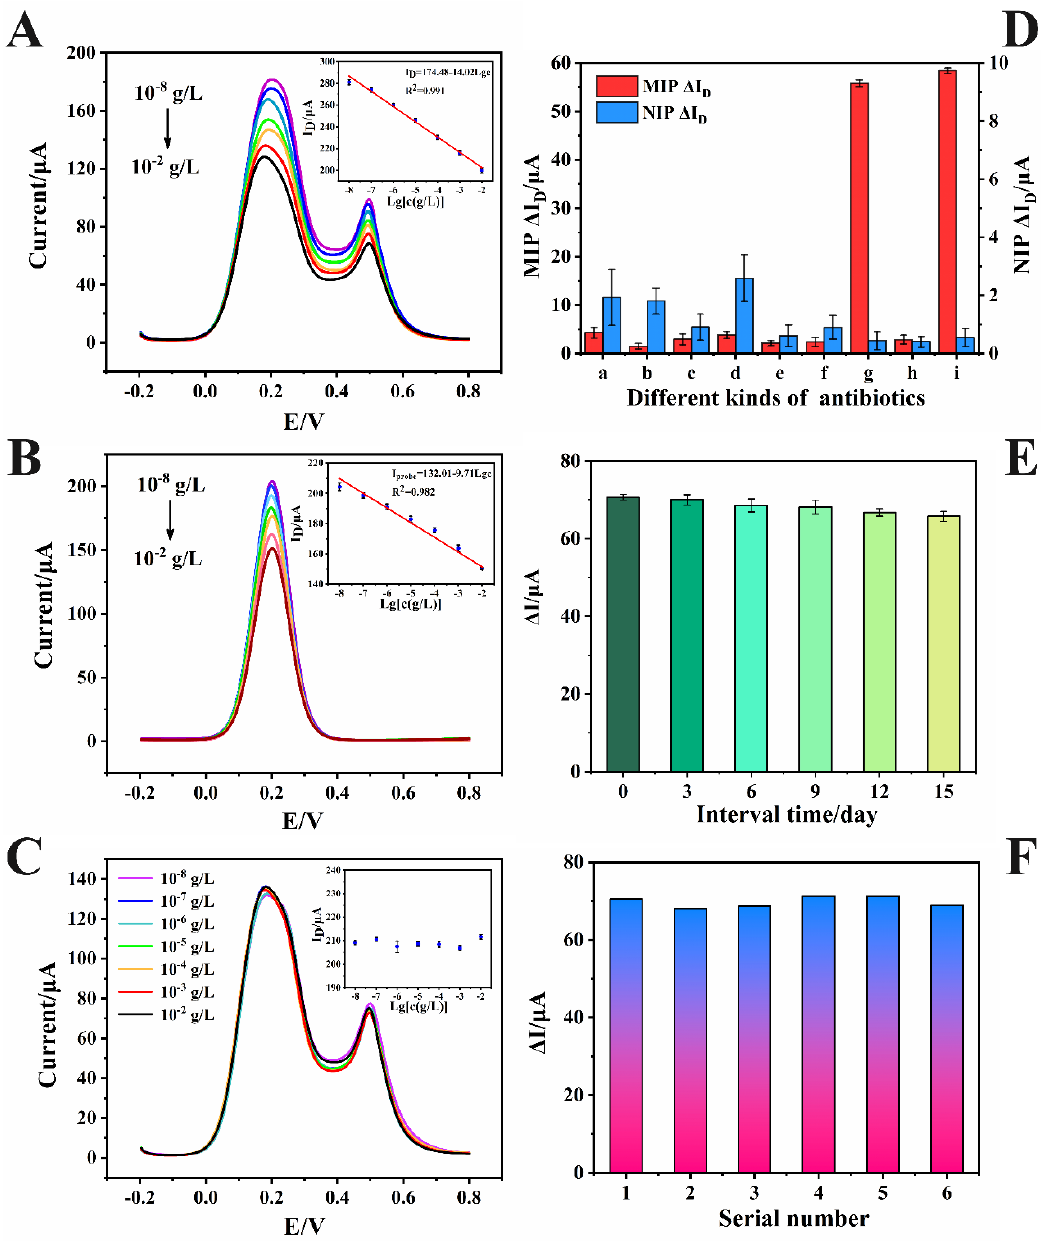
Figure 5. ( A ) DPV response for SiO 2 -COOH@MIPs/SnS 2 /NiFe-PBA/GCE in solutions containing 5 mmol/L [Fe(CN) 6 ] 3-/4- and 0.1 mol/L KCl relative to various concentrations of CAP from 10 -8 g/L to 10 -2 g/L. Illustration: Plot of linear calibration with R 2 = 0.991. ( B ) DPV response for SiO 2 -COOH@MIPs/SnS 2 /GCE in solutions containing 5 mmol/L [Fe(CN) 6 ] 3−/4− and 0.1 mol/L KCl relative to various concentrations of CAP from 10 -8 g/L to 10 -2 g/L. Illustration: Plot of linear calibration with R 2 = 0.982. ( C ) DPV response for SiO 2 -COOH@NIPs/SnS 2 /NiFe-PBA/GCE in solutions containing 5 mmol/L [Fe(CN) 6 ] 3 − /4 − and 0.1 mol/L KCl relative to various concen- trations of CAP from 10 − 8 g/L to 10 − 2 g/L. Illustration: There was no linear relationship. The SiO 2 -COOH@MIPs/SnS 2 /NiFe-PBA/GCE plots of ( D ) specificity ((a) florfenicol; (b) ofloxacin; (c) nor- floxacin; (d) thiamphenicol; (e) kanamycin; (f) tetracycline; (g) chloramphenicol; (h) a–f; (i) Table 1. Comparative study of this work with previously reported sensors for the detection of CAP. Linear Range Method